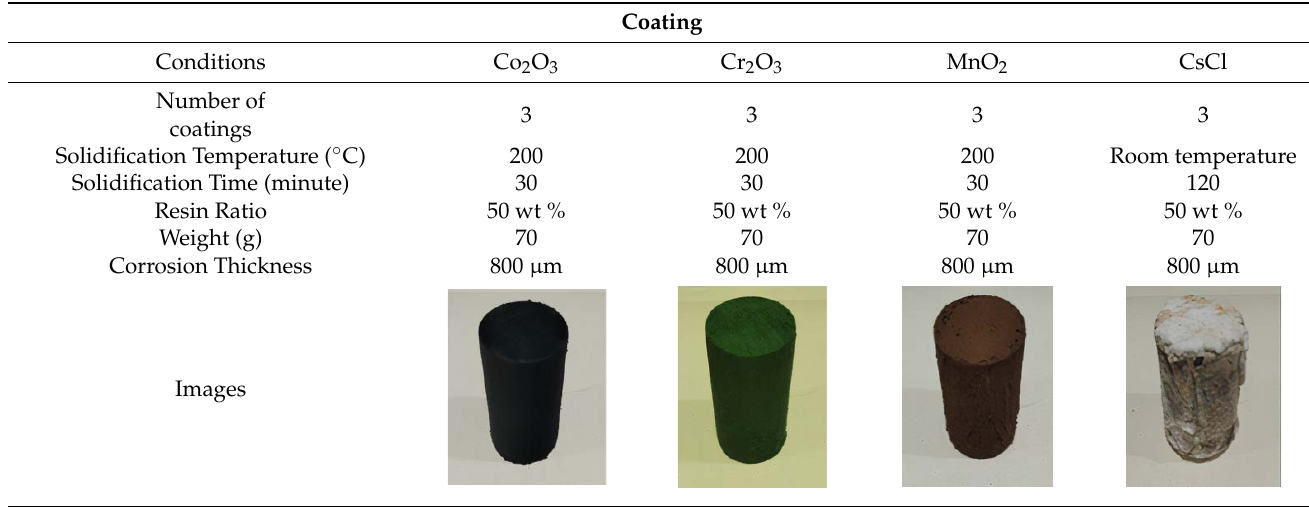
Figure 4. Changes in corrosion thickness according to time. After 12 h of corrosion, the corroded thickness can reach 800 μm. Table 6. S41C specimen fabrication methods.